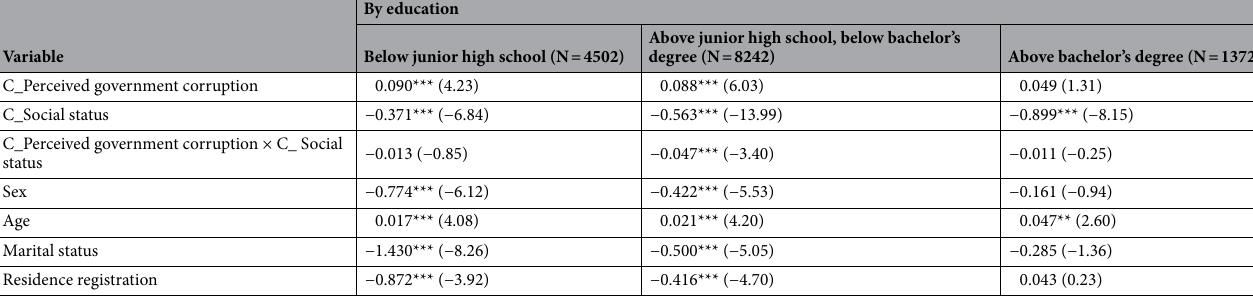
Table 8. Heterogeneity analyses results (N = 14,116). t-values in parentheses, ***p < 0.01, **p < 0.05, *p <